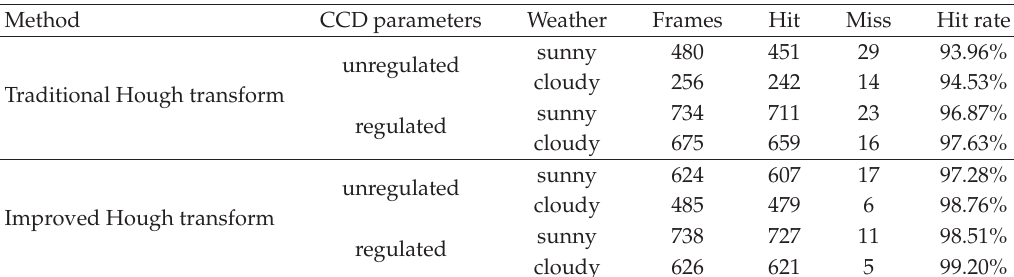
Table 1: Statistics of our lane detection